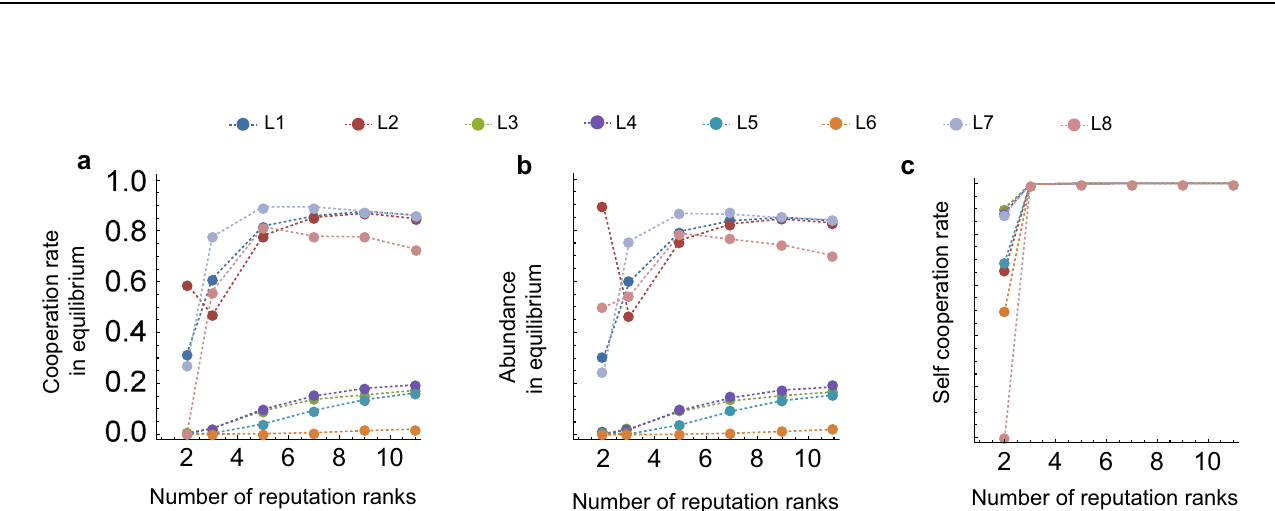
assessment,cooperationratesof L 1, L 2,and L 7remainataround85%evenwhenthe errorrate ε increasesto0.1.Thegenerallymoreunstable L 8ismoreaffectedbythe increasednoise,butstillremainsabove50%evenat ε =0.1. b Increasingthebene fi t of cooperation b leads to an increase in cooperation rate for all eight considered normsincontrasttothebaseline. c Whenweincreasetheobservationprobability q , the behavior of the leading eight norms ’ cooperation rates is also markedly dif- ferent from the baseline. L 1, L 7 are barely affected while L 2 and L 8 exhibit non- linearity for intermediate values of q